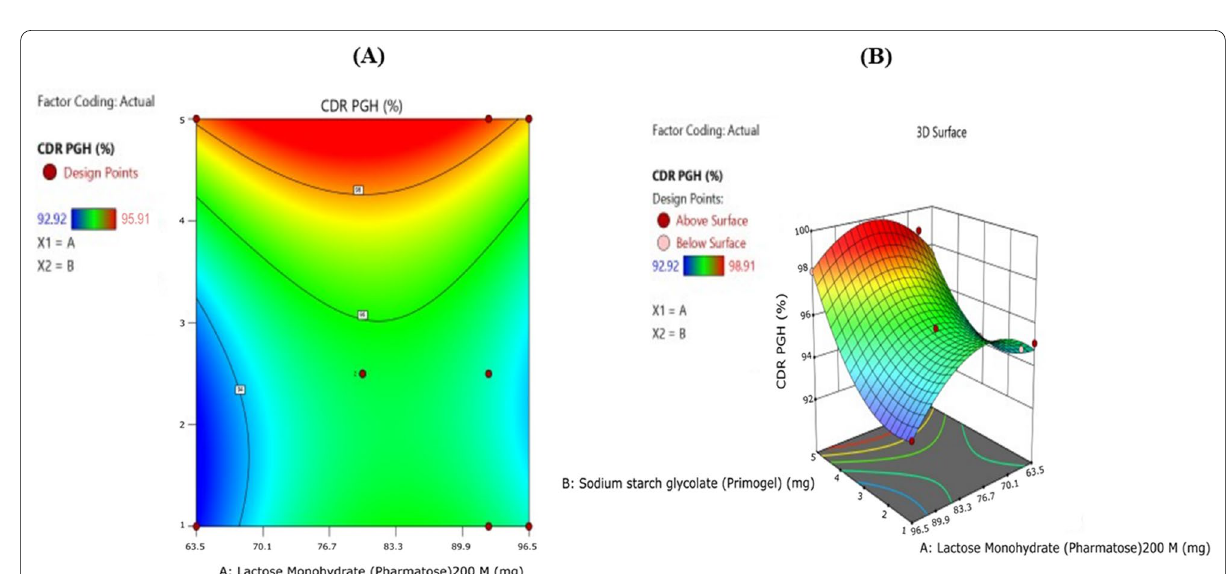
Fig. 6 A Contour plot and B Response surface plot for dependent variables of PGH-IR pellets with %CDR as a